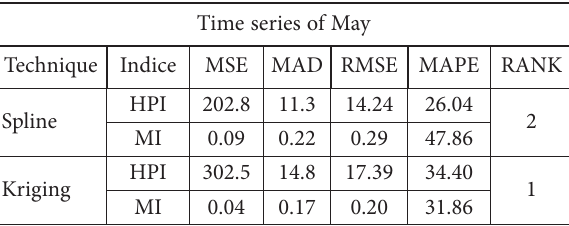
Table 2. The ranking of sptaial interpolation